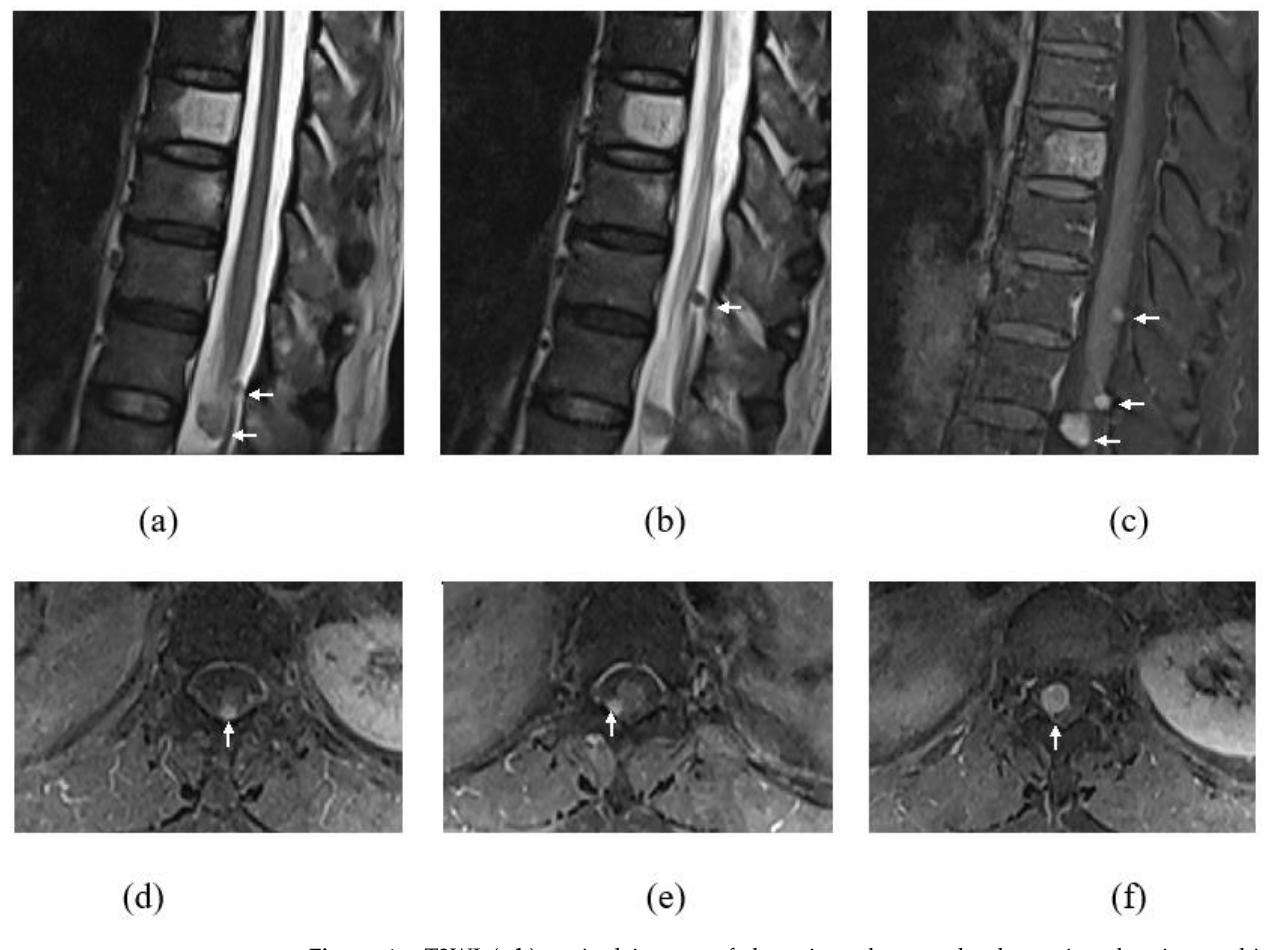
Figure 1. T2WI ( a , b ) sagittal images of thoracic and upper lumbar spine showing multiple (white arrows) intradural extramedullary lesions at T11, T12 and T12/L1 levels. Gadolinum-T1FS sequence in sagittal ( c ) and axial ( d – f ) planes showing enhancement of all these lesions. Owing to the presence of cervical cord compression, which was causing progressive clinical symptoms, he was subjected to a C4–C5 laminectomy accomplished via a posterior approach. A dural opening revealed a firm tumor anterior to the dentate ligament, arising from the right C4 nerve rootlet. The tumor was excised in total, and the involved nerve rootlet was sacrificed. Intraoperative diagnoses of neurofibroma or schwannoma were then